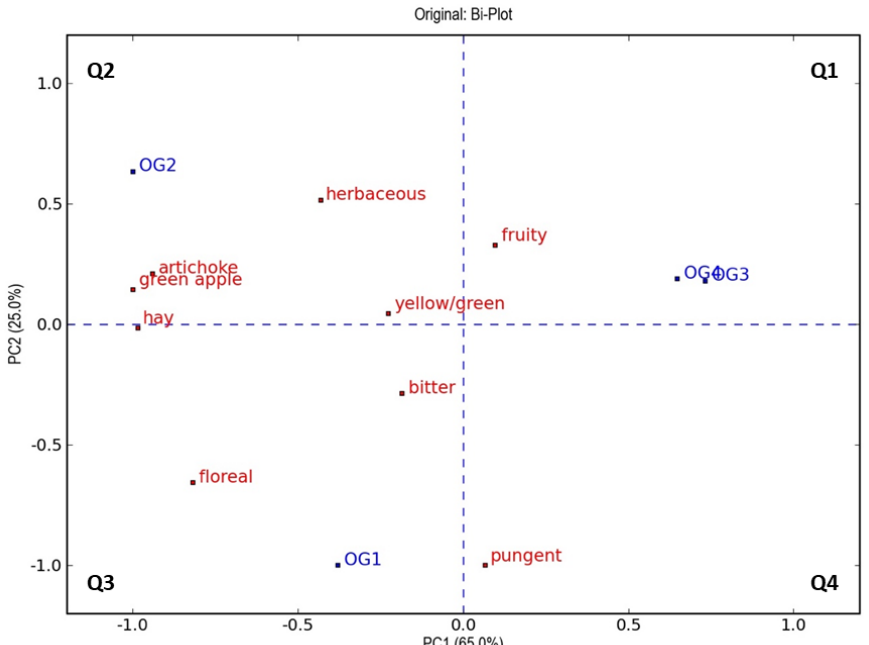
Figure 3. Representation of objects and variables (bi ‐ plot) on the plane of the two principal compo ‐ nents (PCA) relating to the results obtained through sensory evaluations of all virgin olive oils of cv. Ogliarola (objects) and attributes (variables) evaluated at the panel test. The variables and objects are marked in red and blue, respectively. The four quadrants are coded as Q1–Q4